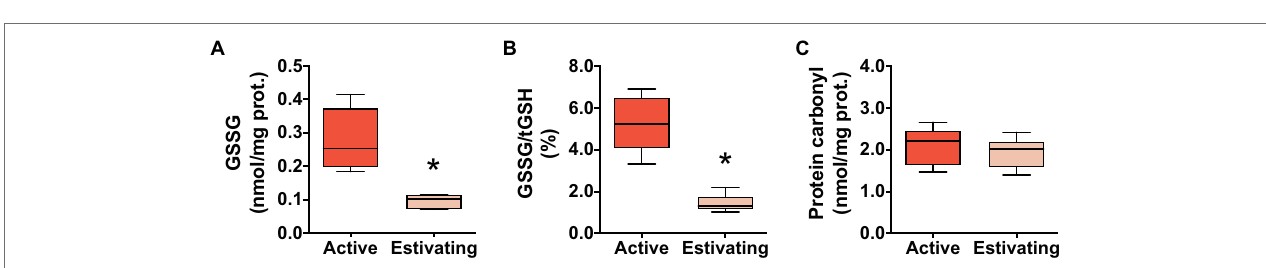
FIGURE 3 | Levels of glutathione (total and reduced) and glutathione transferase activity in the skeletal muscle of Pleurodema diplolister collected during the dry season (estivating) or the rainy season (active). (A) Total glutathione (tGSH). (B) Reduced glutathione (GSH). (C) Glutathione transferase. There were no significant differences between active and estivating groups. N = 6.